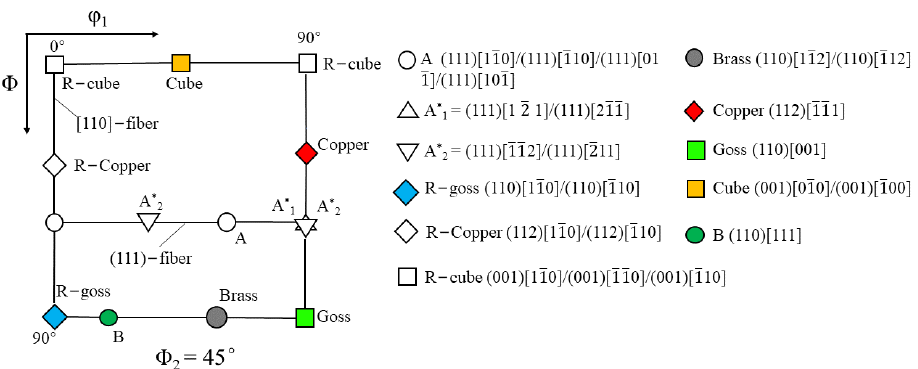
Figure 13. The most ideal texture of aluminum and the corresponding Miller index on the ODF section when ϕ 2 = 45 ◦ [30].